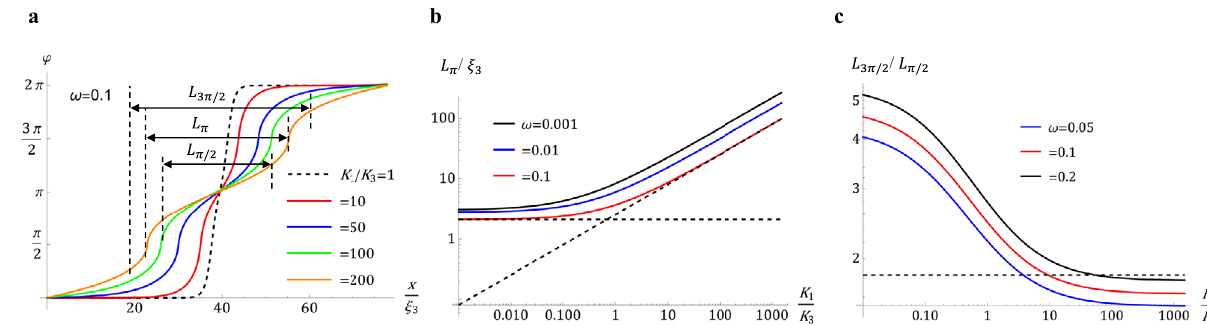
Fig. 7 Equilibrium planar ππ soliton-soliton pairs for different splay and bend constants. a Director pro fi les of DWs pairs for ω = 0.1 and different elastic ratios K 1 / K 3 . b The width parameter L π vs K 1 / K 3 for different anchoring anisotropies ω . c Ratio of width parameters L 3 π /2 / L π /2 vs K 1 / K 3 for different anchoring anisotropies ω ; the dashed line shows L 3 π /2 / L π /2 = 1.8 obtained by averaging experimental data for 64 DW